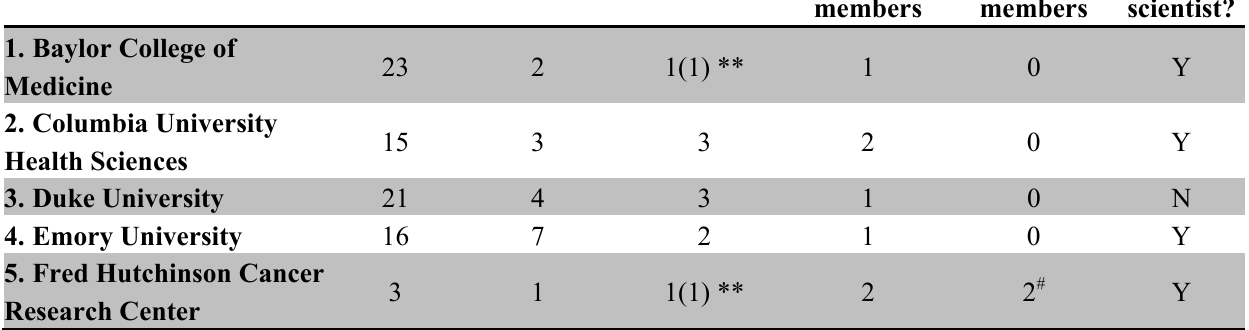
Table 2. IACUC composition at top 25 NIH-funded